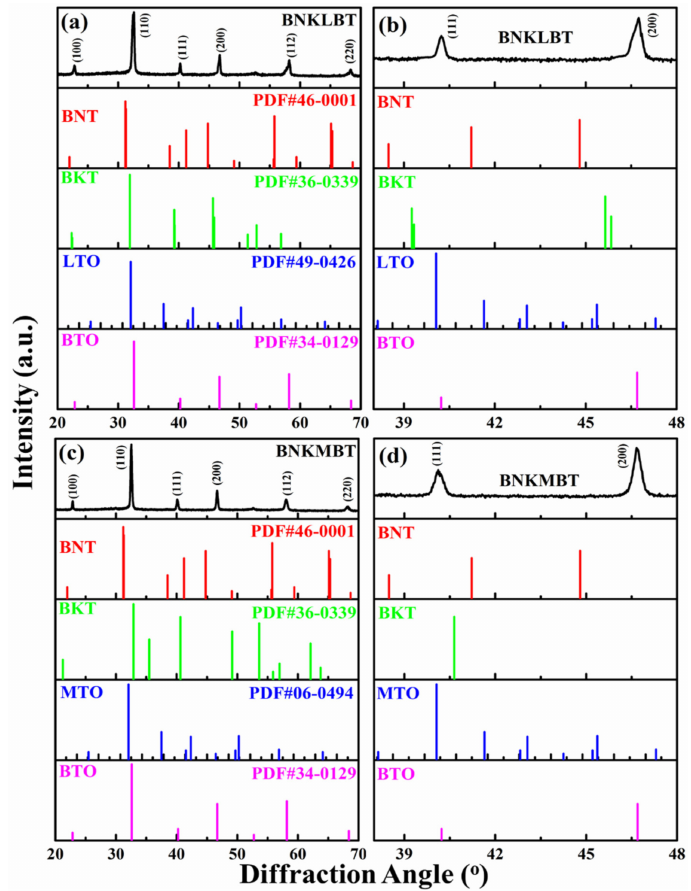
Figure 1. ( a , c ) XRD analysis comparison of high-entropy BNKLBT and BNKMBT ceramics with standard PDF card# data. ( b , d ) Amplified XRD analysis (2 θ = 38–48 ◦ ) of BNKLBT and BNKMBT ceramics, respectively, clearly showing structural distortion of the fabricated ceramics.